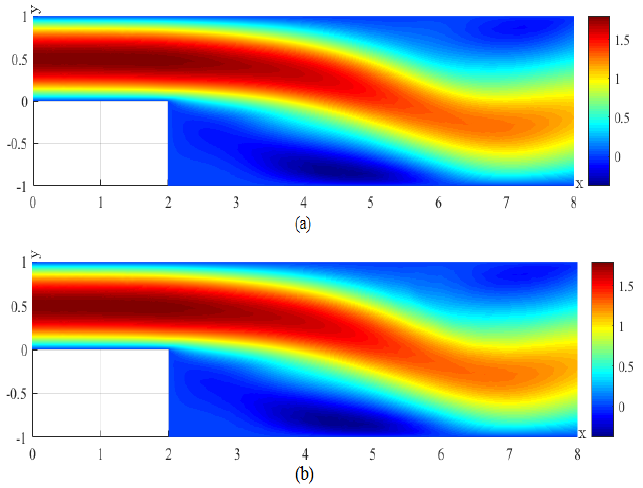
Figure 6. ( a ) The CNMFE solution for u at t = 6. ( b ) The RDRCNMFE solution for u at t = 6.